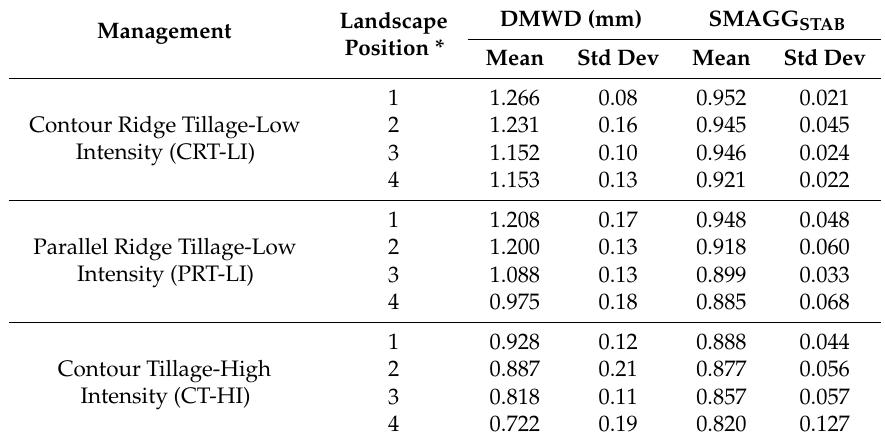
Table 2. Mean and standard deviation values of the dry mean weight diameter (DMWD) and small macroaggregate stability (SMAGG STAB ) measured along the flowpaths for each sampled site.